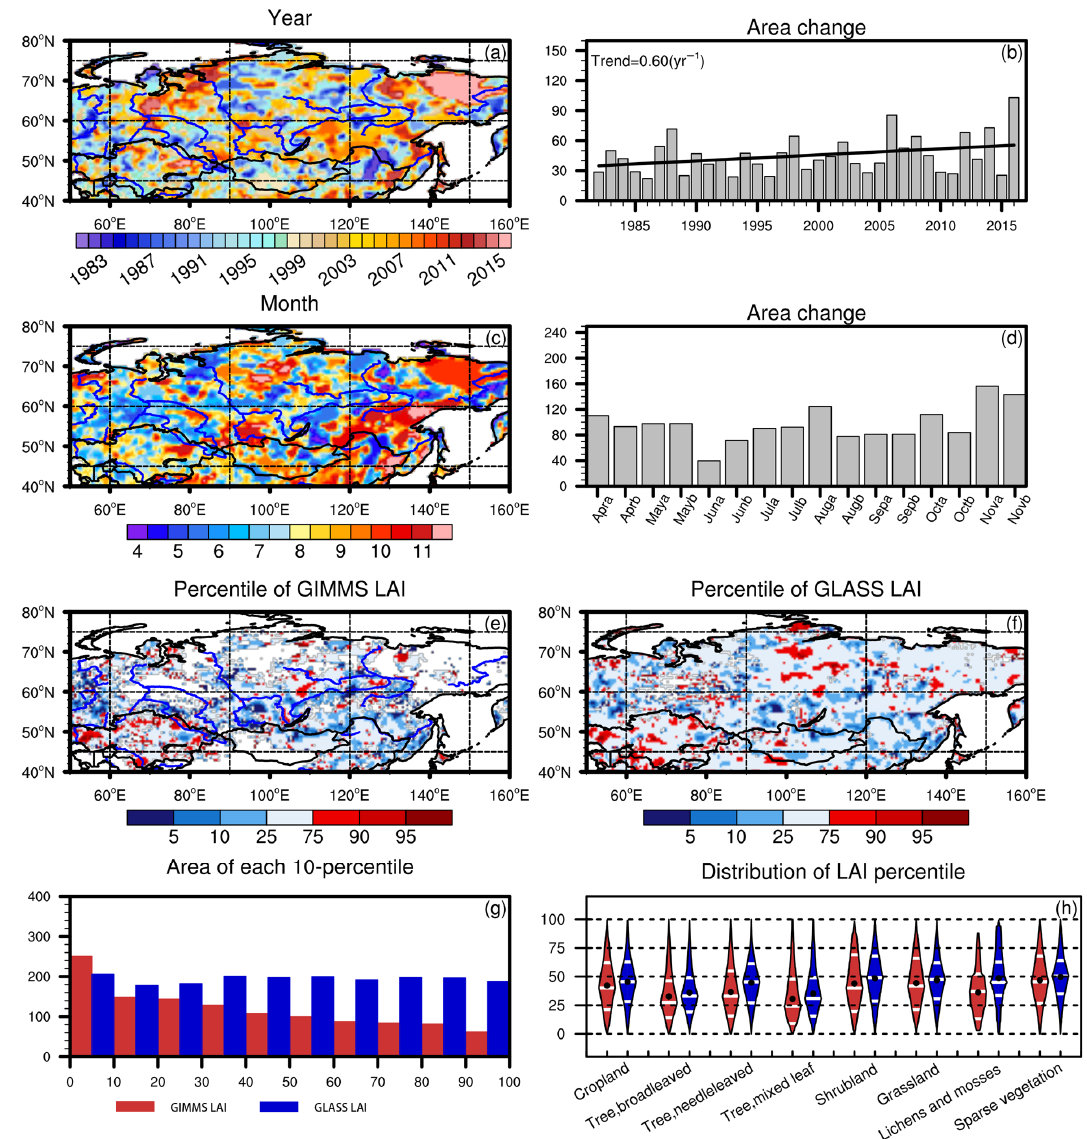
Figure 8. Same as Figure 5, but for the LAI when the maximum precipitation was recorded. Years ( a ), half-months ( c ), and percentiles of GIMMS LAI ( e ) and GLASS LAI ( f ) when the maximum precipitation was recorded, and the corresponding accumulated areas (unit in 10 4 km 2 . ( b , d , g ). The box plot ( h ) shows the percentile of the LAI for different vegetation types, with the white lines showing the 25th, 50th, and 75th percentiles, and the dots showing the averages. The line in b is the linear trend calculated by least-squares